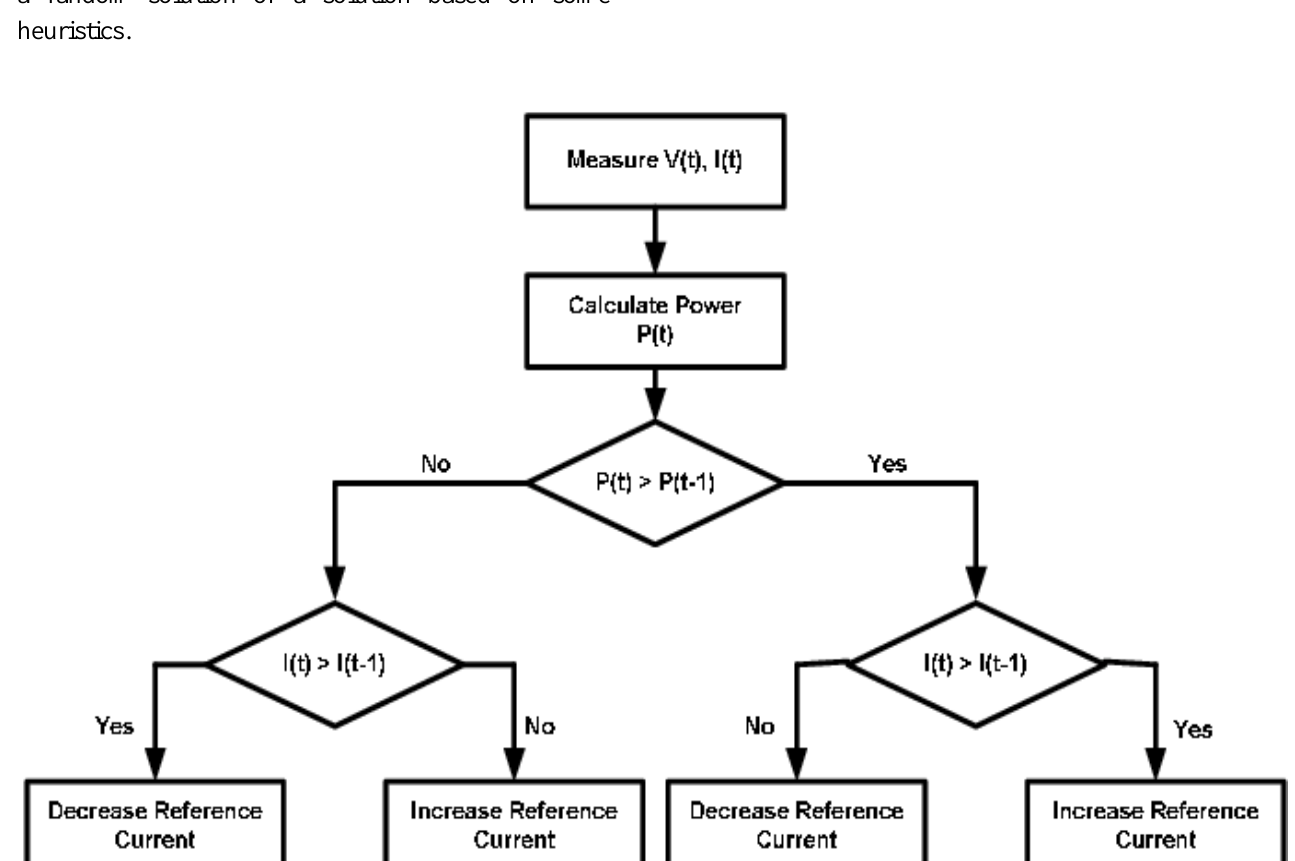
Fig. 2. Flowchart of hill climbing